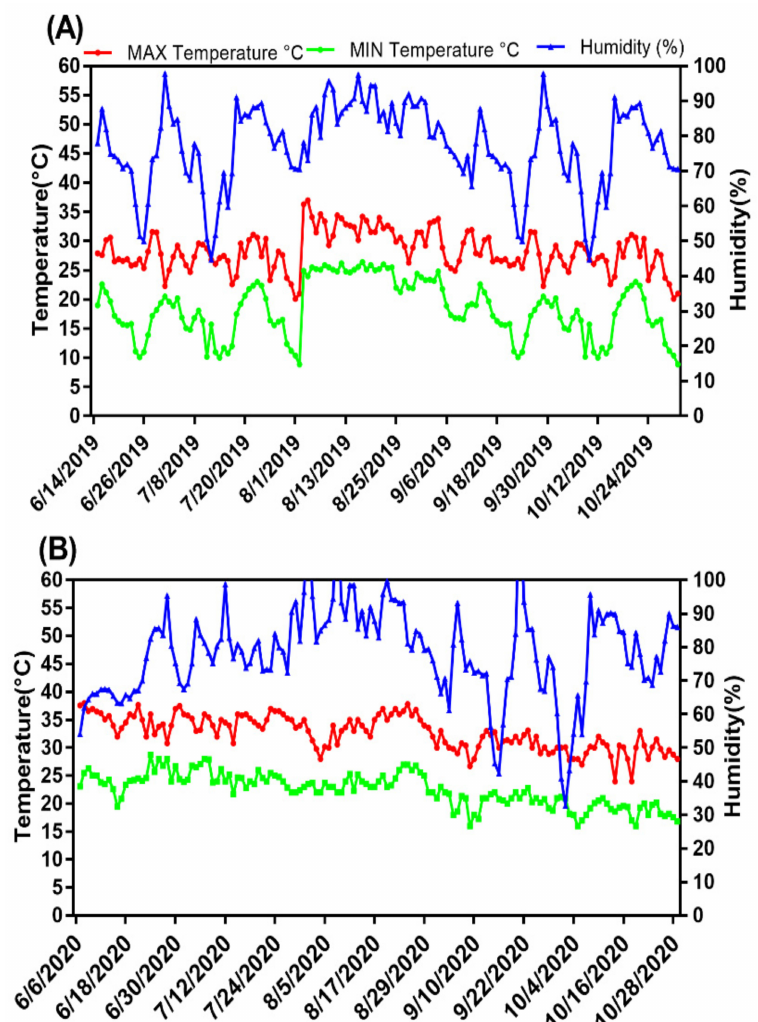
Figure 1. Averages of temperature and humidity during both experiment seasons for ( A ) 2019 and ( B )